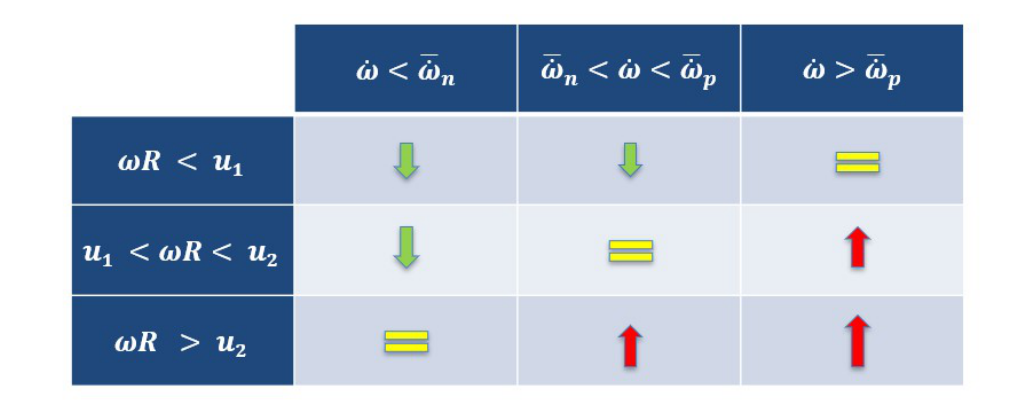
Figure 2. Standard ABS